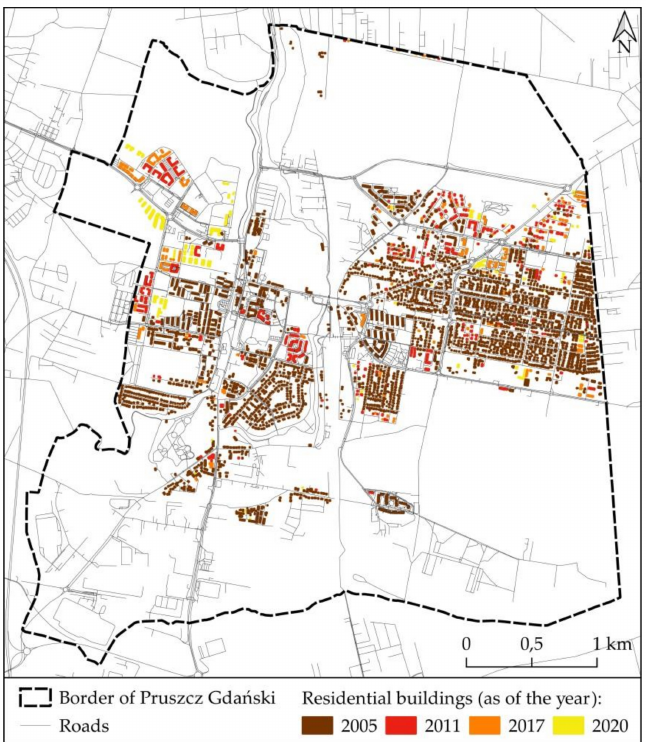
Figure 3. Changes in the housing development in the town of Pruszcz Gda´nski in 2005–2020 (source: own elaboration based on